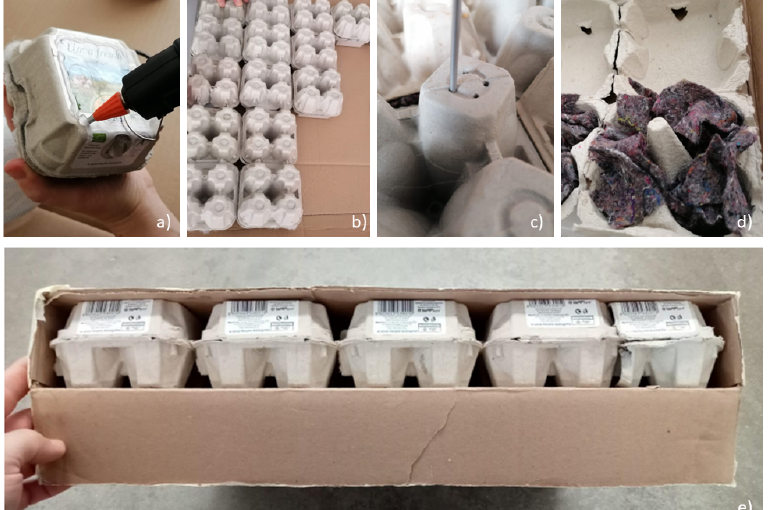
Figure 2. The realization of the panels: egg boxes have been glued onto a cardboard panel ( a , b ); holes have been drilled in each egg box dome ( c ); the egg boxes have been filled with textile waste (in this picture, the filling is made of felt) ( d ); the external case has been completed ( e ).